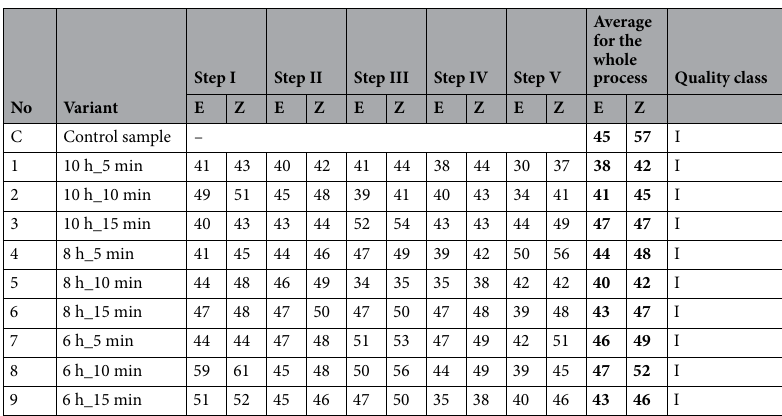
Step I Step II Step III Step IV Step V